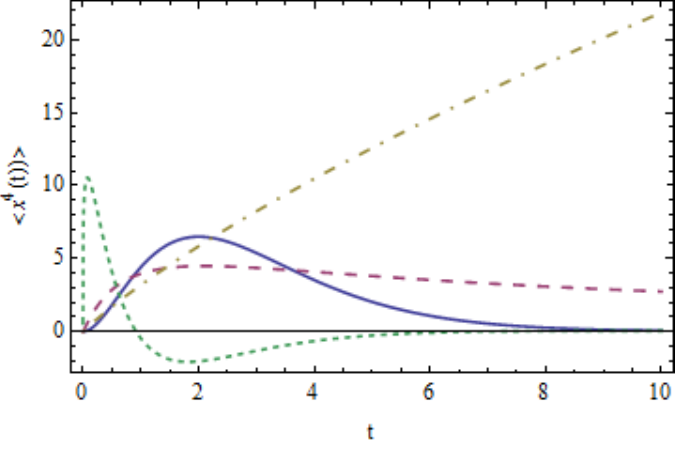
Figure 3. Graphical representation of the fourth moment (59) for 1  